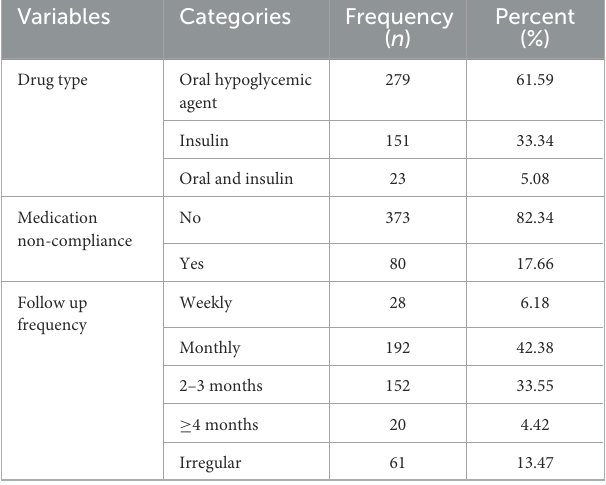
TABLE 3 Treatment-related results of adult patients with diabetes in Bahir Dar public hospitals, North West Ethiopia, 2021 ( n = 453).